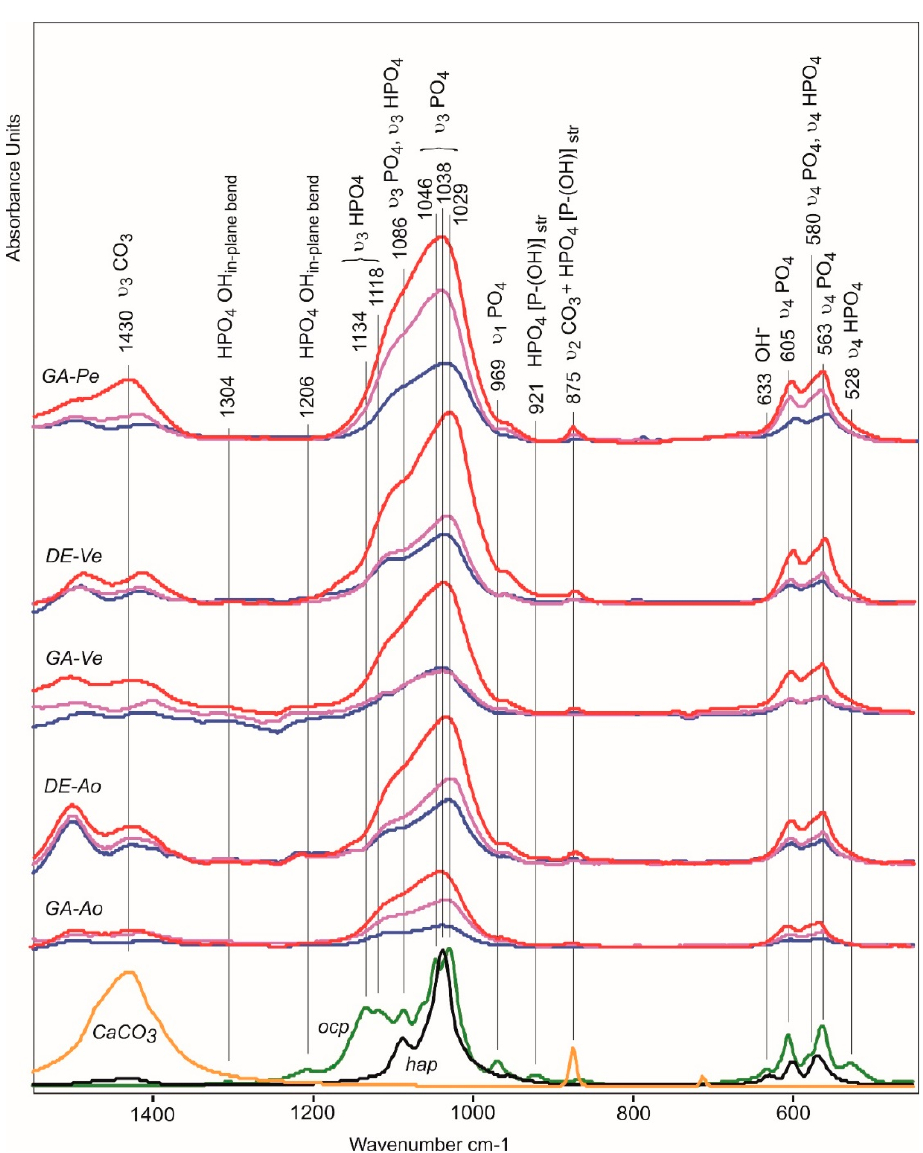
Figure 6. FTIR difference spectra as a result of subtraction of the non-implanted biomaterials spectra from spectra of implants after 10 (blue line), 20 (pink), and 30 (red) days of implantation. Bottom— spectra of calcium carbonate (yellow), octacalcium phosphate ( ocp , green), and hydroxyapatite ( hap , black).